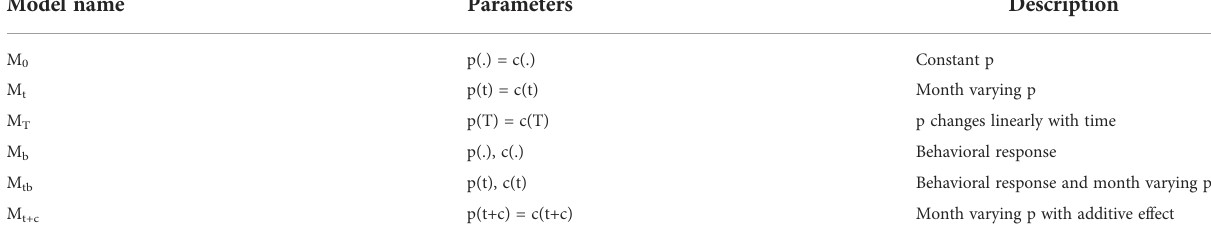
TABLE 1 List of models fi tted to the common dolphin ’ s